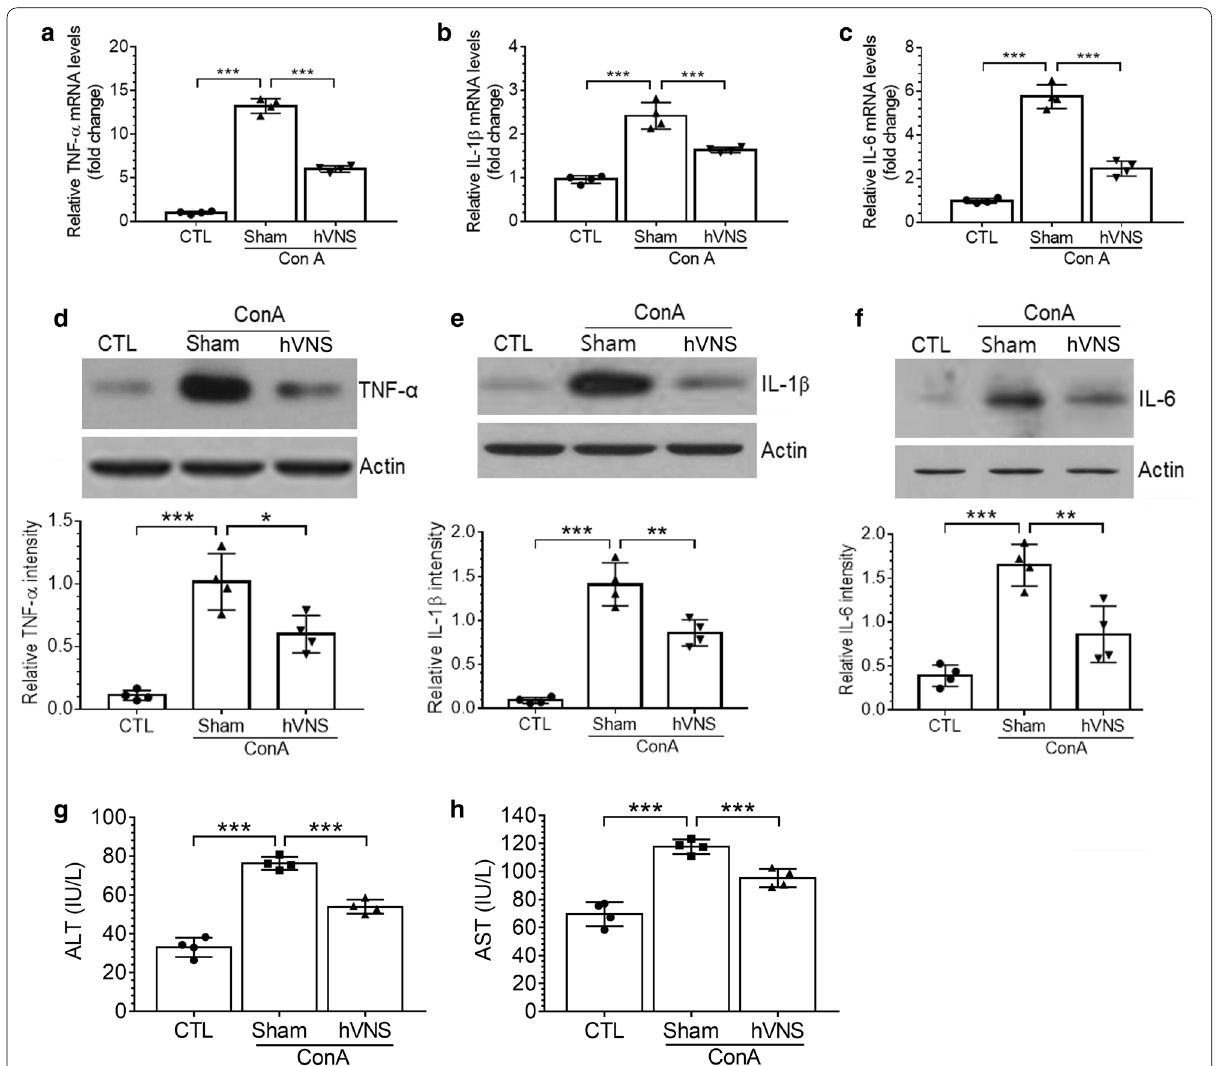
Fig. 1 Down‑regulation of the production of inflammatory cytokine mRNAs and proteins by hVNS in ConA‑injected animals. hVNS was administered 24 h after ConA injection and the liver tissue was dissected for real‑time PCR and western blot analyses 24 h later. a – c Quantification of mRNAs for TNF‑α, IL‑1β, and IL‑6 by real‑time PCR. Levels of target mRNA in ConA (CTL) are plotted. d – f Western blotting of TNF‑α, IL‑1β, and IL‑6 proteins in the liver tissue. Upper images in d – f are the representatives from four independent experiments and the plots below present quantitative comparison of band intensity relative to actin. Western blotting for actin in d – f as sample loading control. g , h ALT and AST levels in serum of CTL, ConA with Tukey post hoc is shown. *p < 0.05, **p < 0.01, ***p <